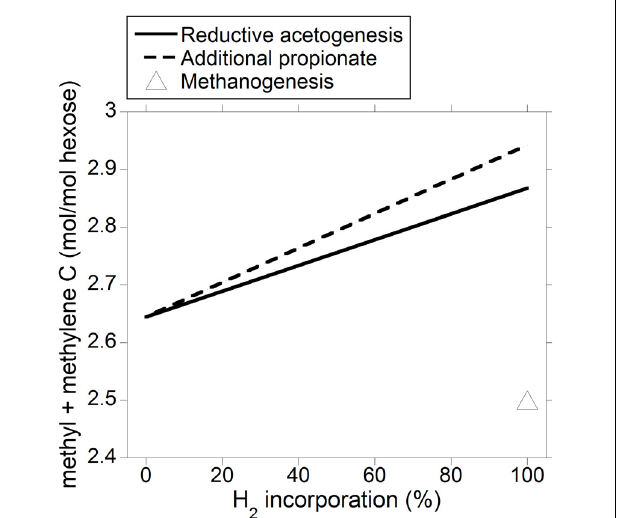
FIGURE 7 | Estimated (cid:2) G of fermentation with H 2 incorporation into reductive acetogenesis or additional propionate formation as a function of H 2 incorporation. Corresponding fermentation with CH 4 as main electron sink is provided as reference.